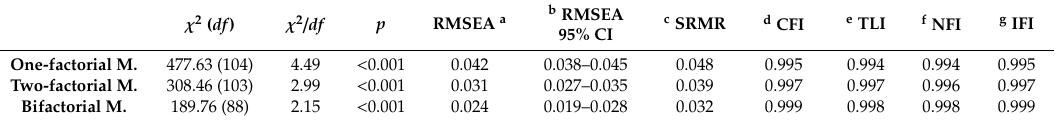
Table 3. Summary of the Confirmatory Factor Analyses (CFA) for single, two, and bifactorial models of depression and anxiety. χ 2 ( df ) χ 2 / df One-factorial